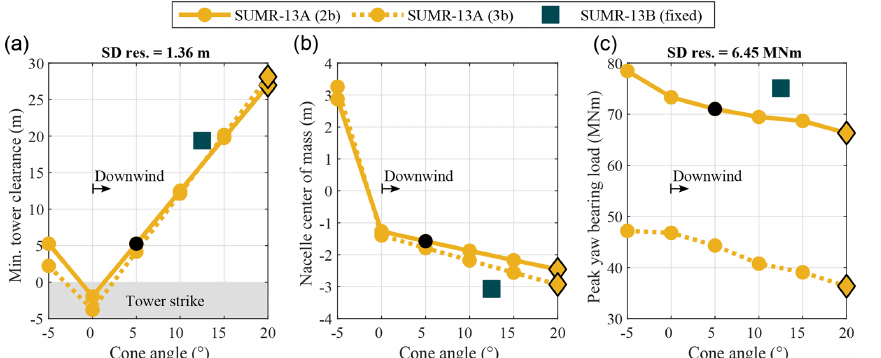
Figure 14. The tower clearance (a) resulting from upwind (negative cone angles) and downwind (positive cone angles) configurations, the nacelle center of mass (b) required to balance the rotors, and the peak yaw-bearing loads (c) of the balanced rotors.